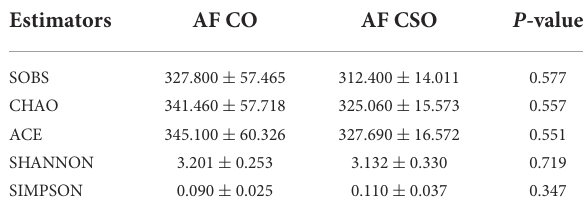
TABLE 3 Alpha diversity